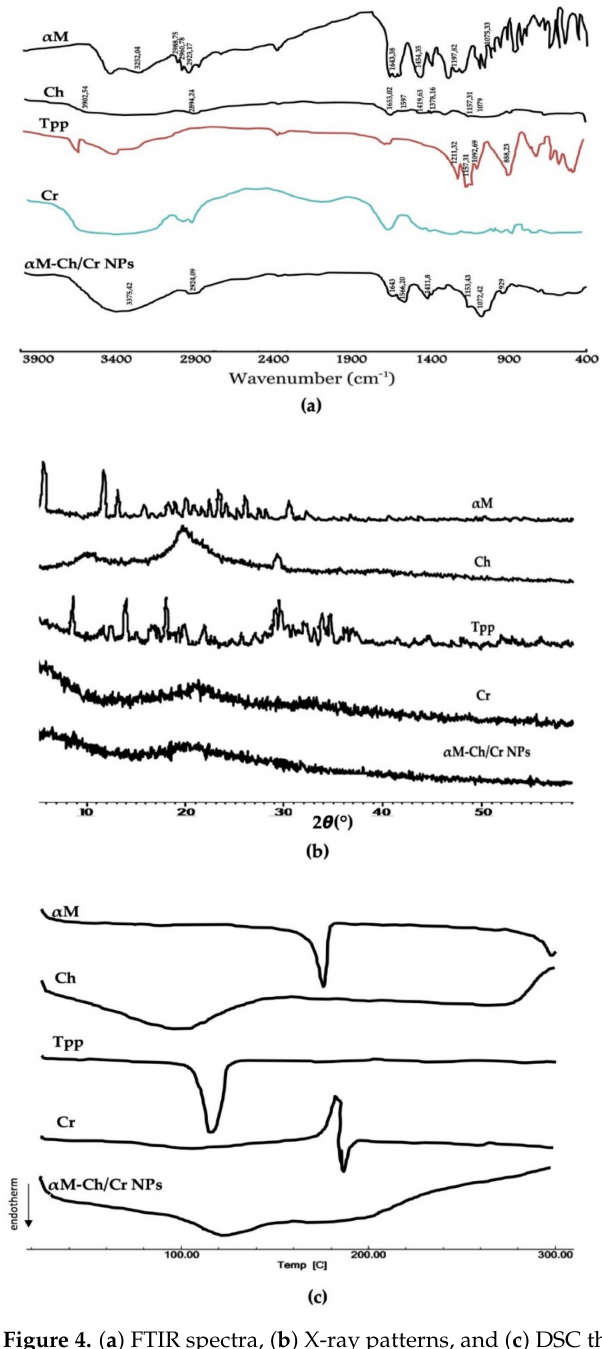
Figure 4. ( a ) FTIR spectra, ( b ) X-ray patterns, and ( c ) DSC thermograms of α -mangostin, chitosan, carrageenan, and α M-Ch/Cr